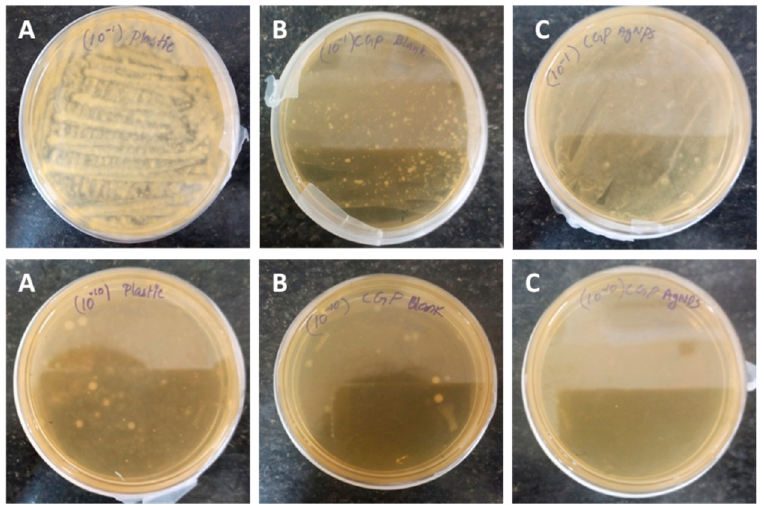
Figure 13. The antibacterial ability of composite films was evaluated through the spread plate method after 10 days of storage: ( A ) Polyethylene films ( B ) CG ( C ) CG4.